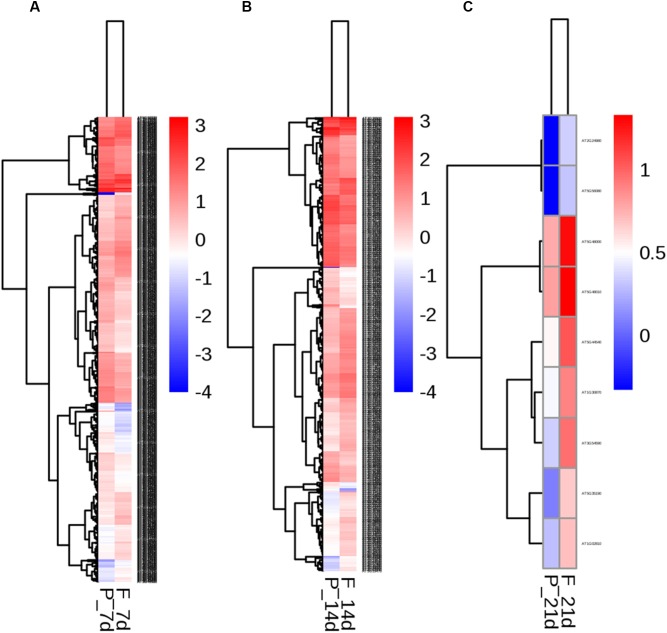
Two-way hierarchical clustering heat map of genes differentially expressed in seedlings in parafilm and paper tape-sealed petri dishes for 7 (A), 14 (B), and 21 days (C). Differentially expressed transcripts were clustered. The color key in the right-hand corner is for the colors in the heat map. Detail information of these DEGs can be found in Tables 3–6.